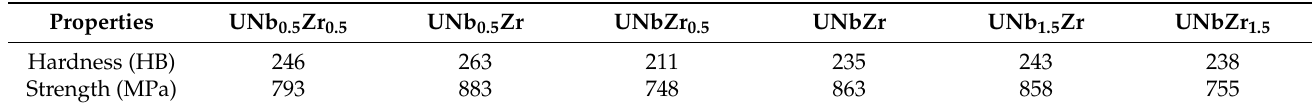
Table 5. Hardness and strength of the U-Nb-Zr alloy system.